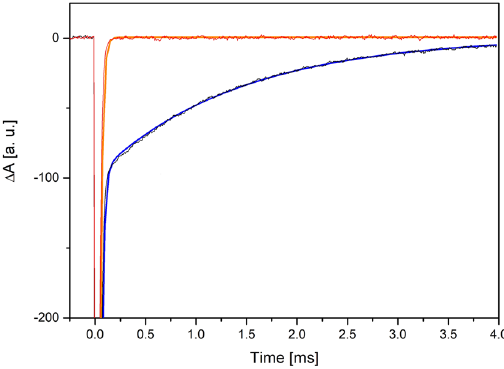
Figure 4. Recovery of the ground state absorption bleaching upon saturating excitation of WSCP Chl a in oxic (red) and anoxic (black) conditions, with the respective fitting curves. Saturating µ s flash centered at the Q y . Low intensity probing light beam centered at the Soret